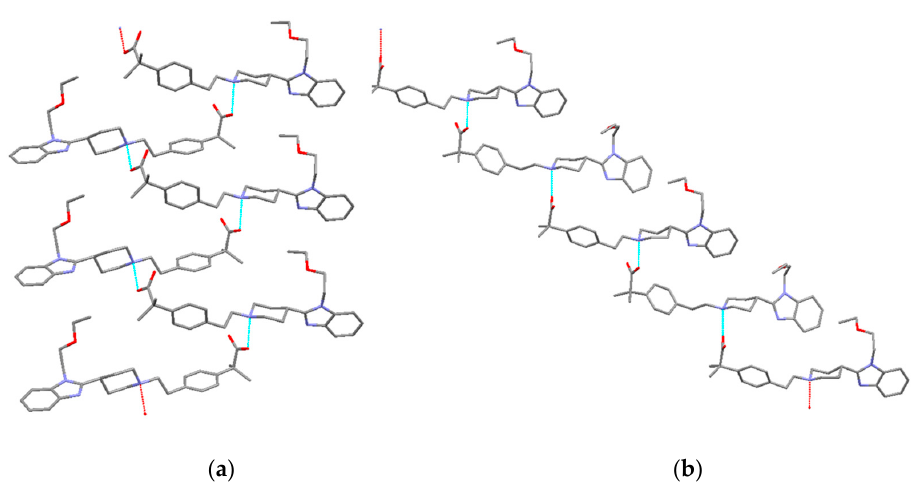
Figure 14. Comparison between the crystal structures of ( a ) form I (corrugated layer) and ( b ) form III (cascade layer) of BL.